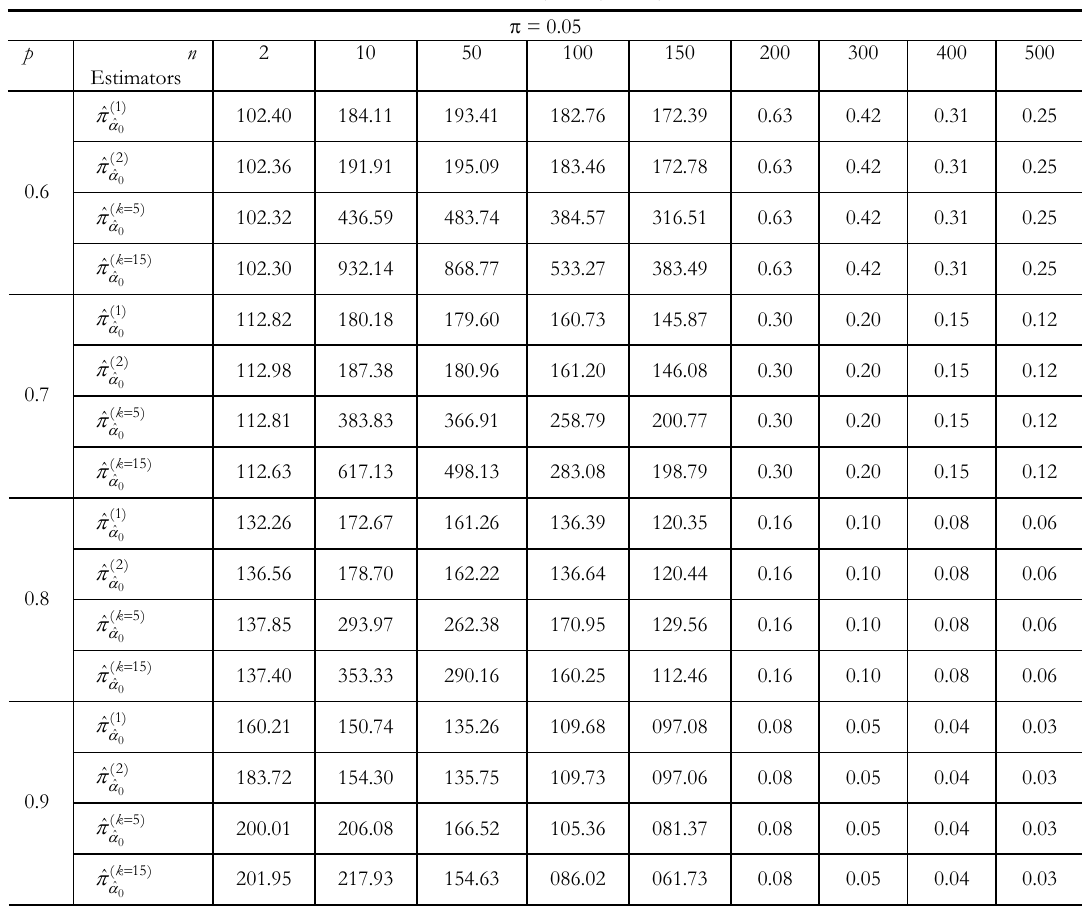
Percent Relative Efficiency